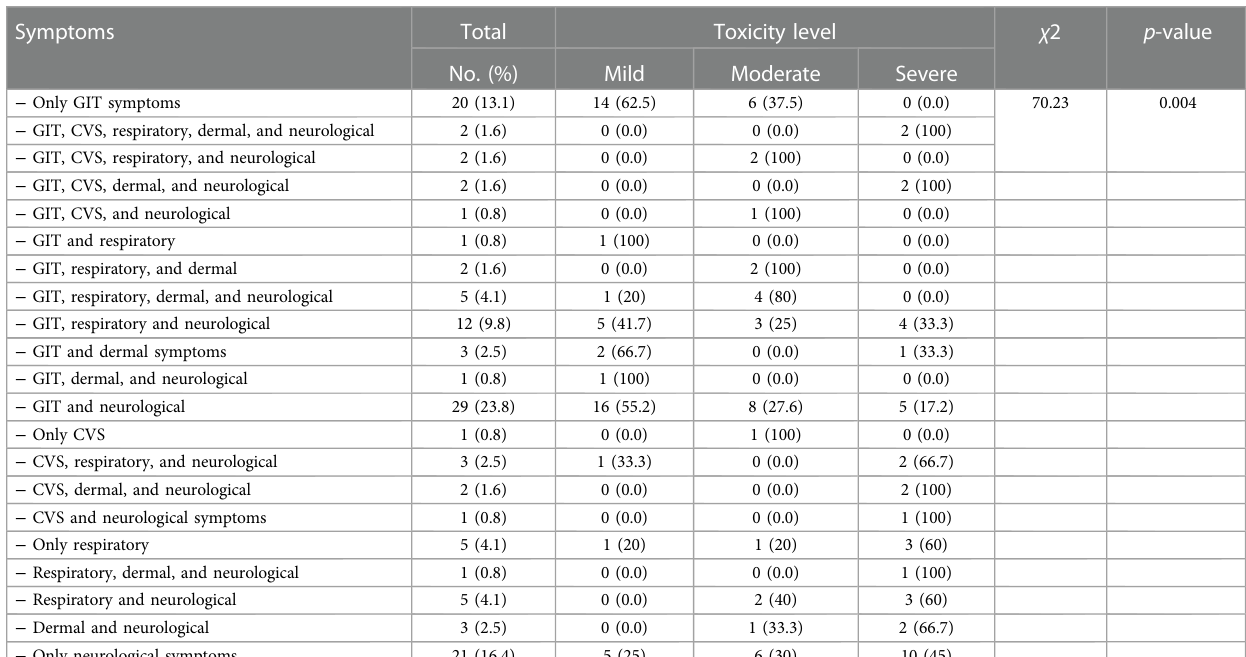
TABLE 3 Relationship between presenting symptoms and level of